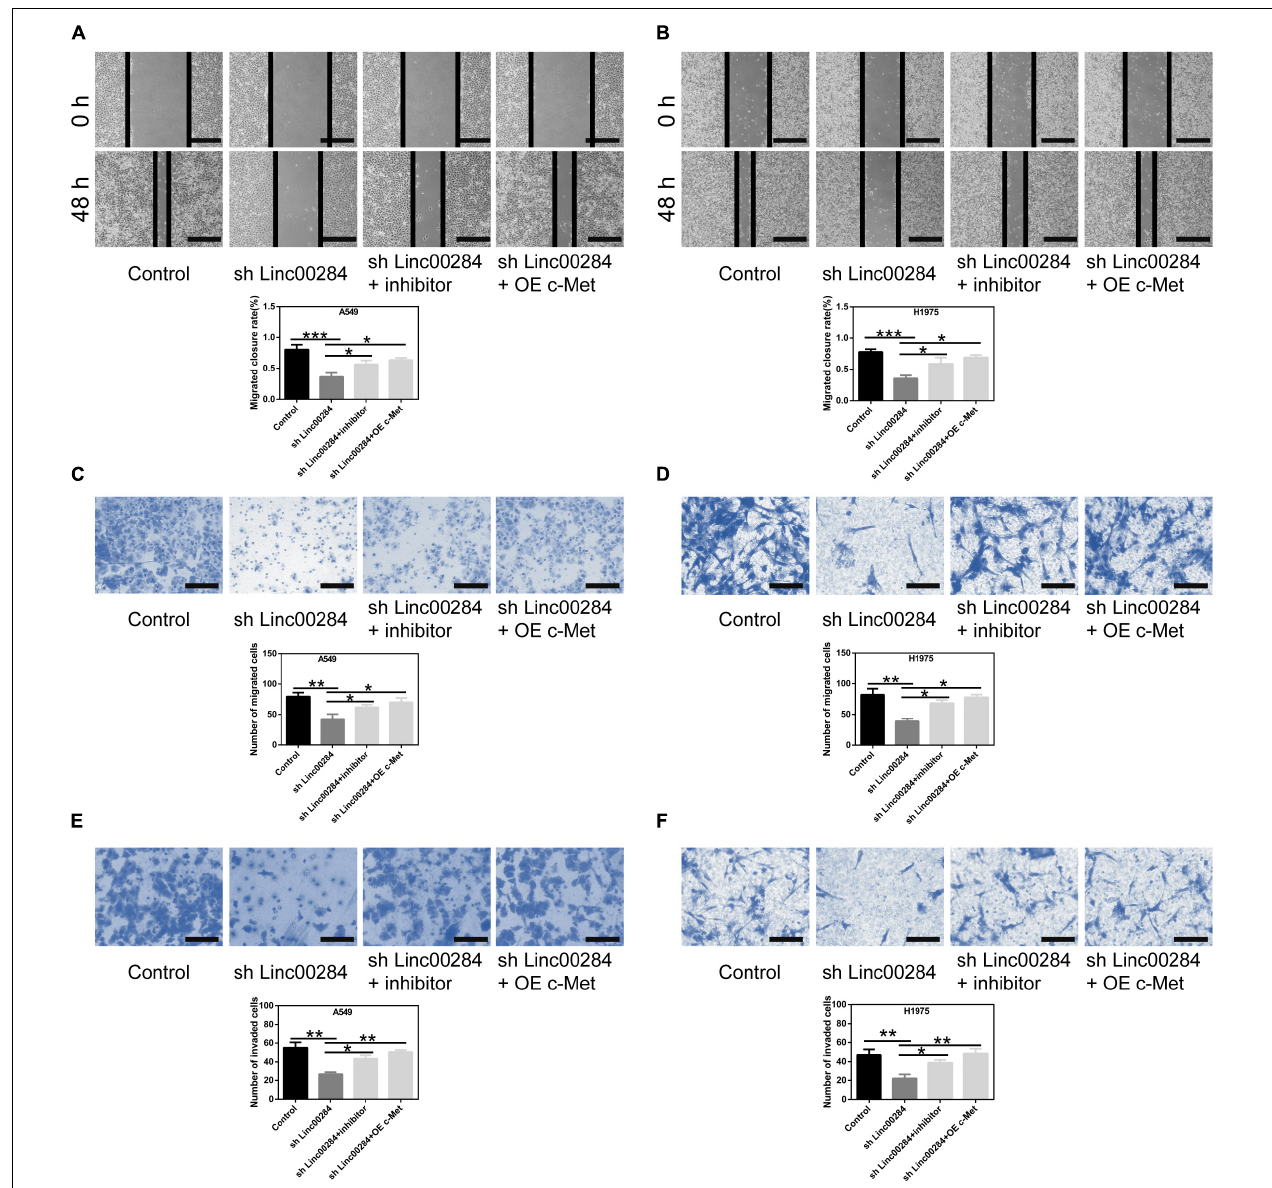
FIGURE 7 | Linc00284/miR-205-3p/c-Met regulatory axis modulates lung cancer cell migration and invasion. (A,B) Wound healing assays were used to test the migratory abilities of (A) A549 and (B) H1975 cells in which Linc00284 was knocked down with miR-205-3p silencing or c-Met overexpression. Magnification, × 4. (C,D) Transwell migration assays were performed to evaluate the migratory capabilities of (C) A549 and (D) H1975 cells in which Linc00284 was knocked down with miR-205-3p silencing or c-Met overexpression. Magnification, × 20. (E,F) Transwell invasion assays were conducted to detect the invasive capabilities of (E) A549 and (F) H1975 cells in which Linc00284 was knocked down with miR-205-3p silencing or c-Met overexpression. Magnification, × 40. Data are expressed as the means ± SD of triplicate independent experiments. Multiple comparisons were analyzed using one-way ANOVA followed by Tukey’s test. * P < 0.05, ** P < 0.01, and *** P < 0.001, compared with the matched control